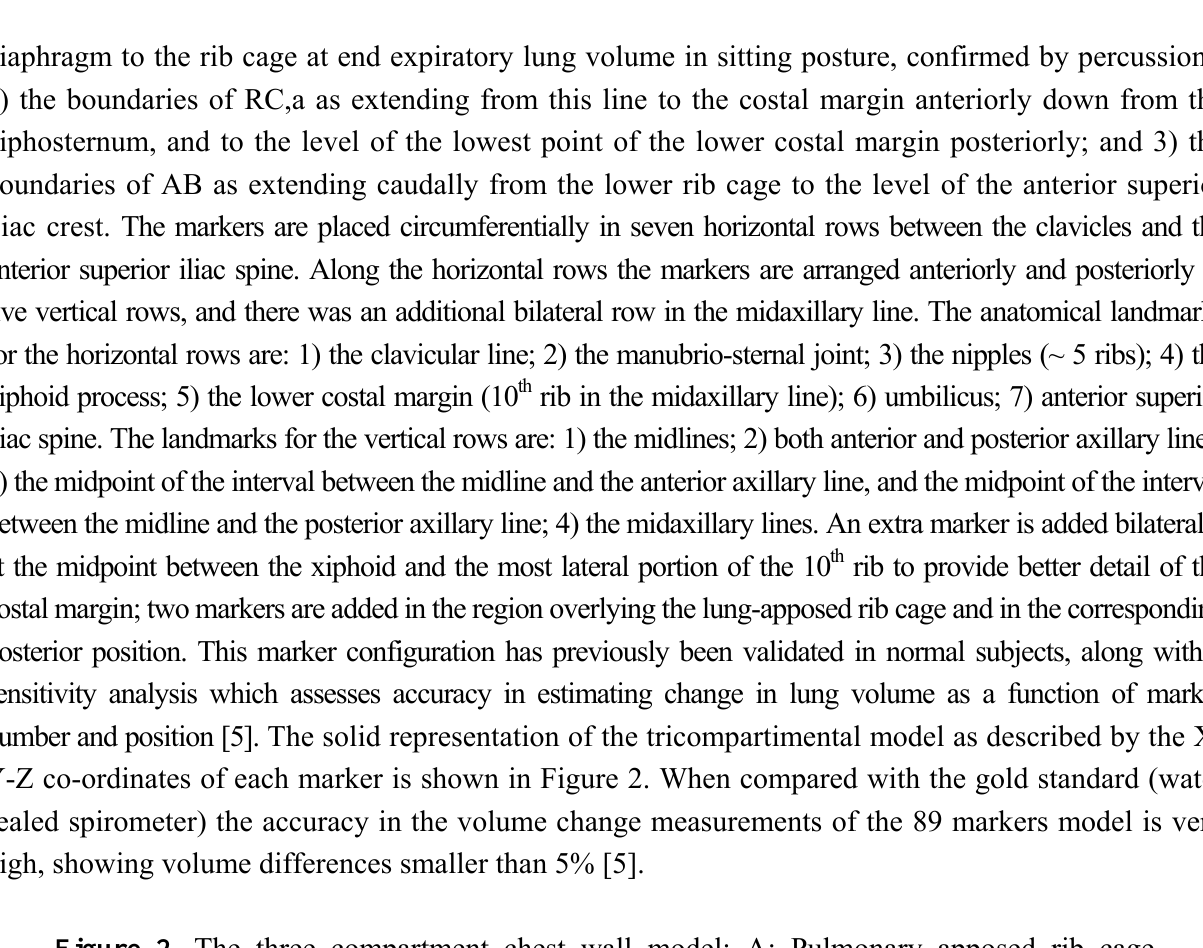
Figure 2. The three compartment chest wall model: A: Pulmonary apposed rib